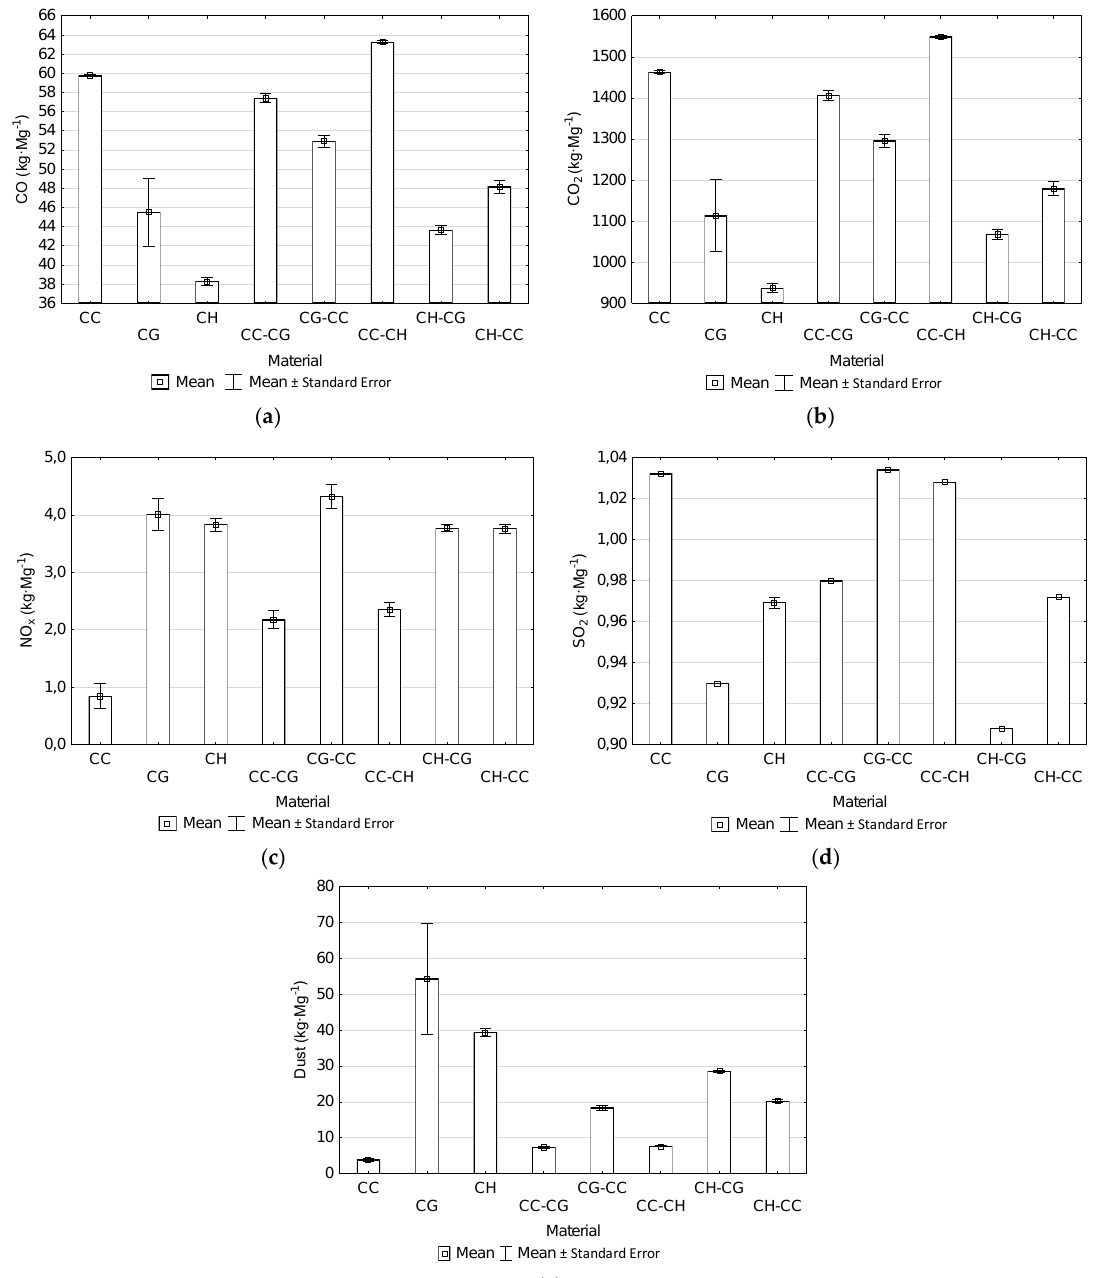
Figure 3. Emission factors for the tested materials (kg·Mg −1 dry mass): ( a ) CO; ( b ) CO 2 ; ( c ) NO x ; ( d ) SO 2 ; ( e ) dust.